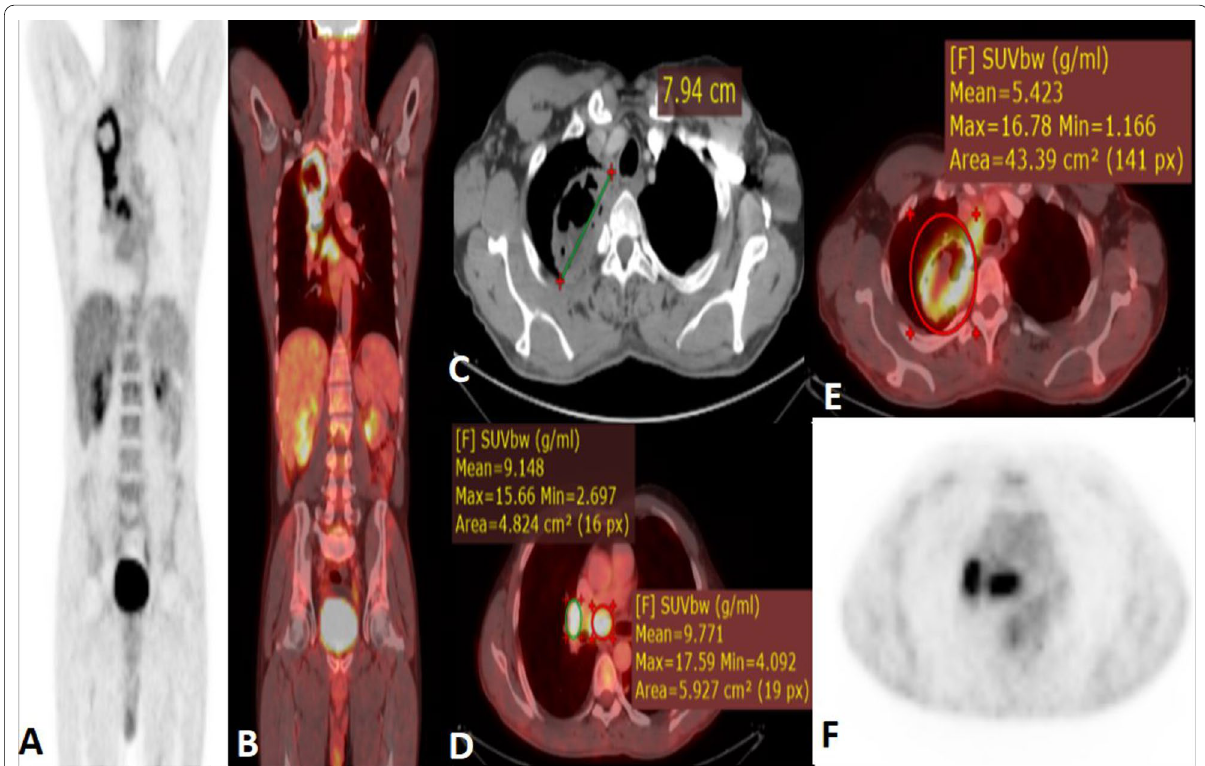
Fig. 6 A 61-year-old male patient proved histopathologically to have squamous cell carcinoma (SCC) involving the right upper lobe. A (coronal PET), B (coronal PET/CT), C (axial CT in a mediastinal window), D , E (axial PET/CT images), F (axial PET). The mass lesion size measured in the C image was 7.94 cm with SUVmax of the tumor was 16.78 as shown in E . TLR was calculated to be 16.78/1.65 10.17. Right hilar and subcarinal = lymphadenopathies were noted ( D and F ) with SUVmax 15.66 and 17.59, respectively =